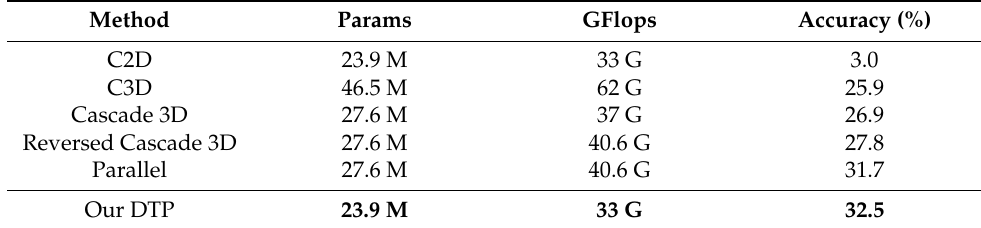
Table 1. Performance of different structures on